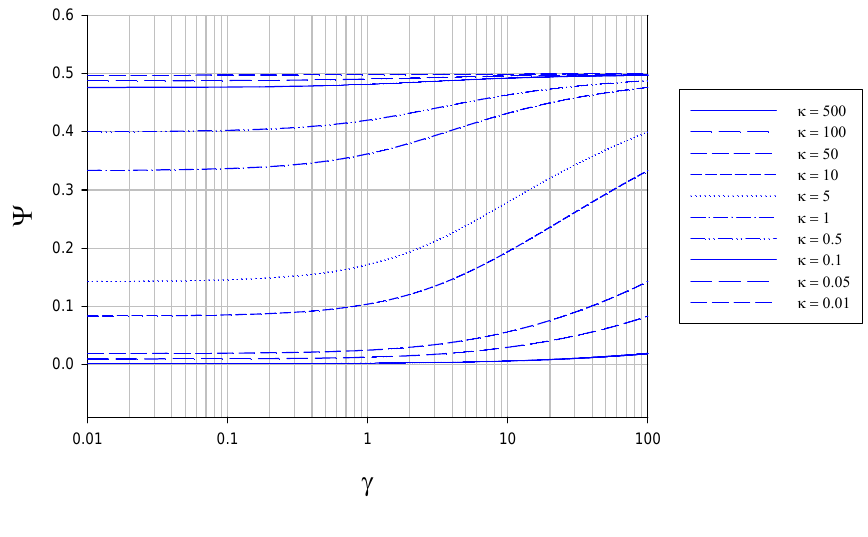
Figure 4. Variation of normalized flux Ψ with reaction/diffusion parameter γ for various fixed values of the parameter κ . The curves were calculated using eqn.13 in the text.